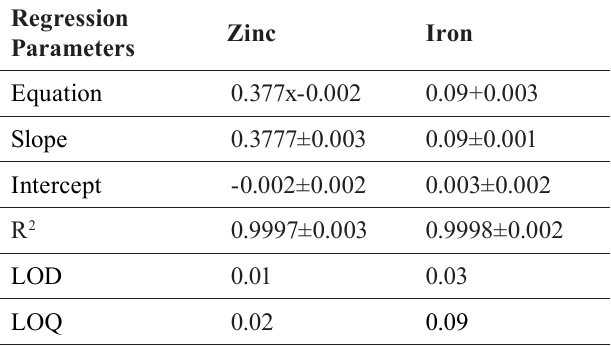
TABLE V - L inearity parameters of iron and zinc